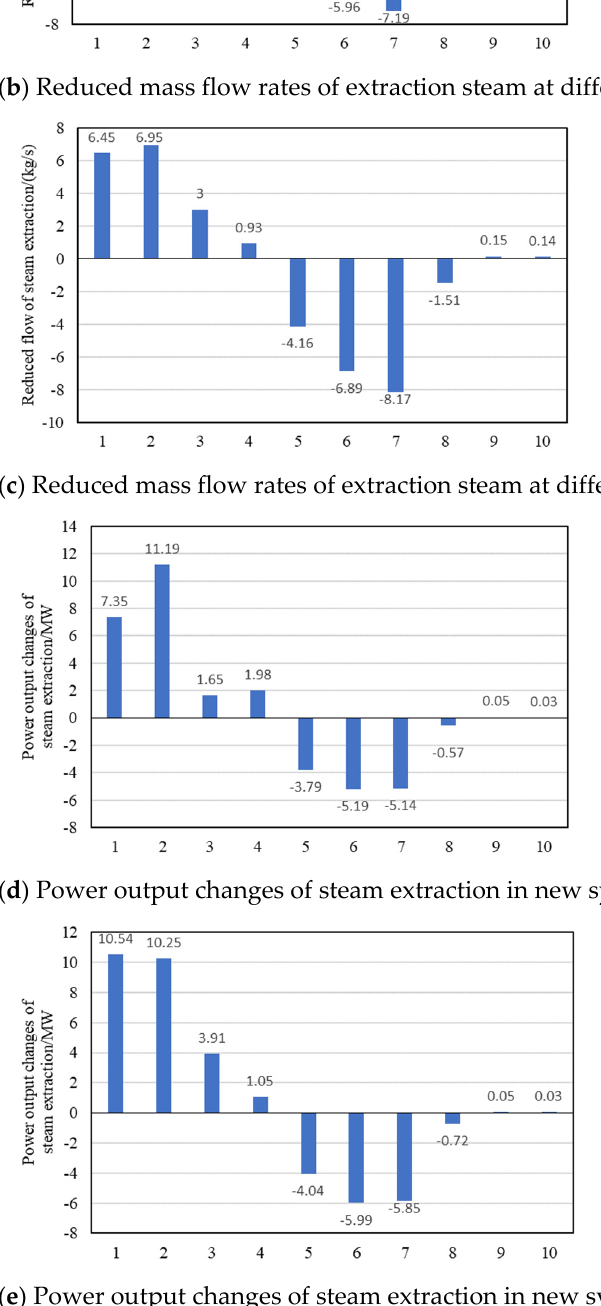
Figure 11. Steam extraction mass flow and power generation capacity.